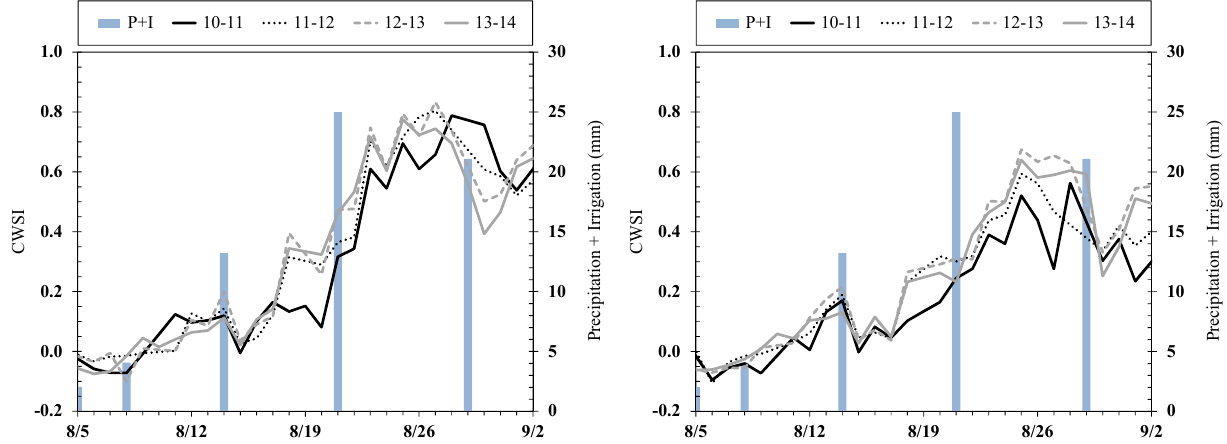
Figure 3. Hourly graphs of Crop Water Stress Index (CWSI) for plots L-1.2 ( left ) and L-2.2 ( right ) during the study period (5 August–2 September 2011).